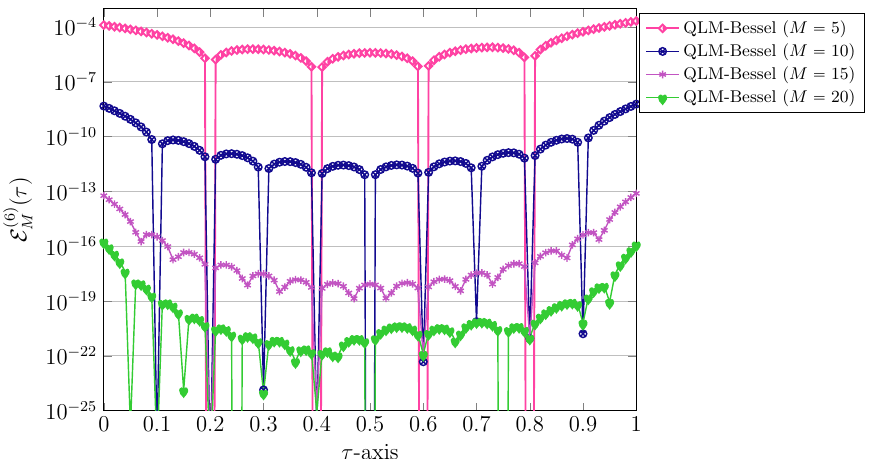
Figure 2. Comparison of residual error functions in QLM-Bessel for various M = 5,10,15,20, and r = 5 in Test case